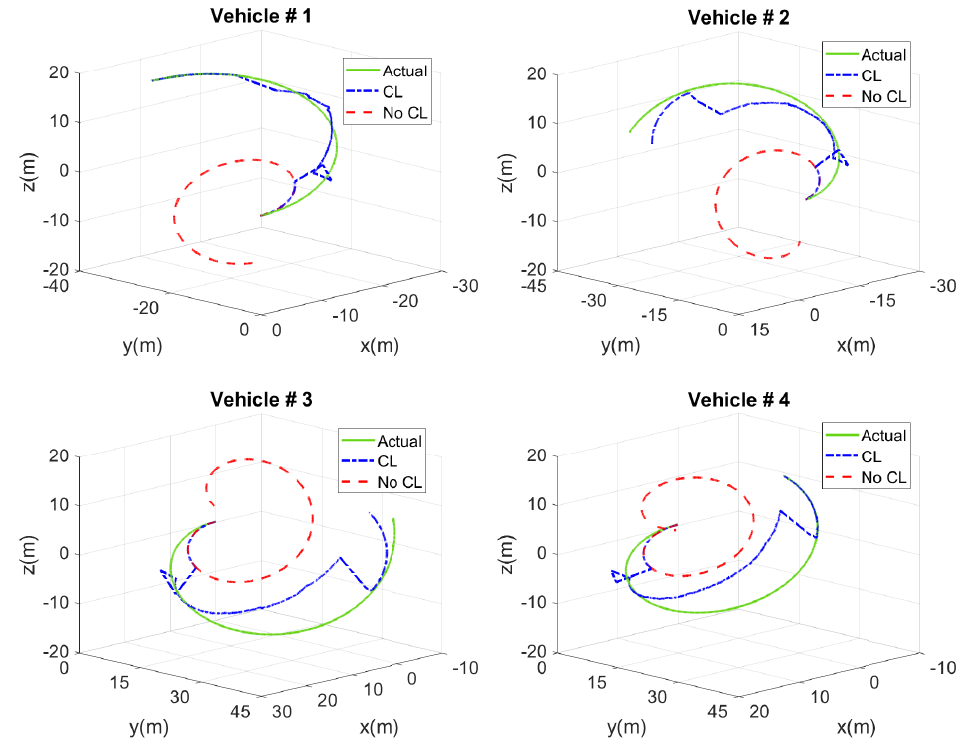
Figure 4. Vehicle actual path versus paths estimated with and without CL in the test case.